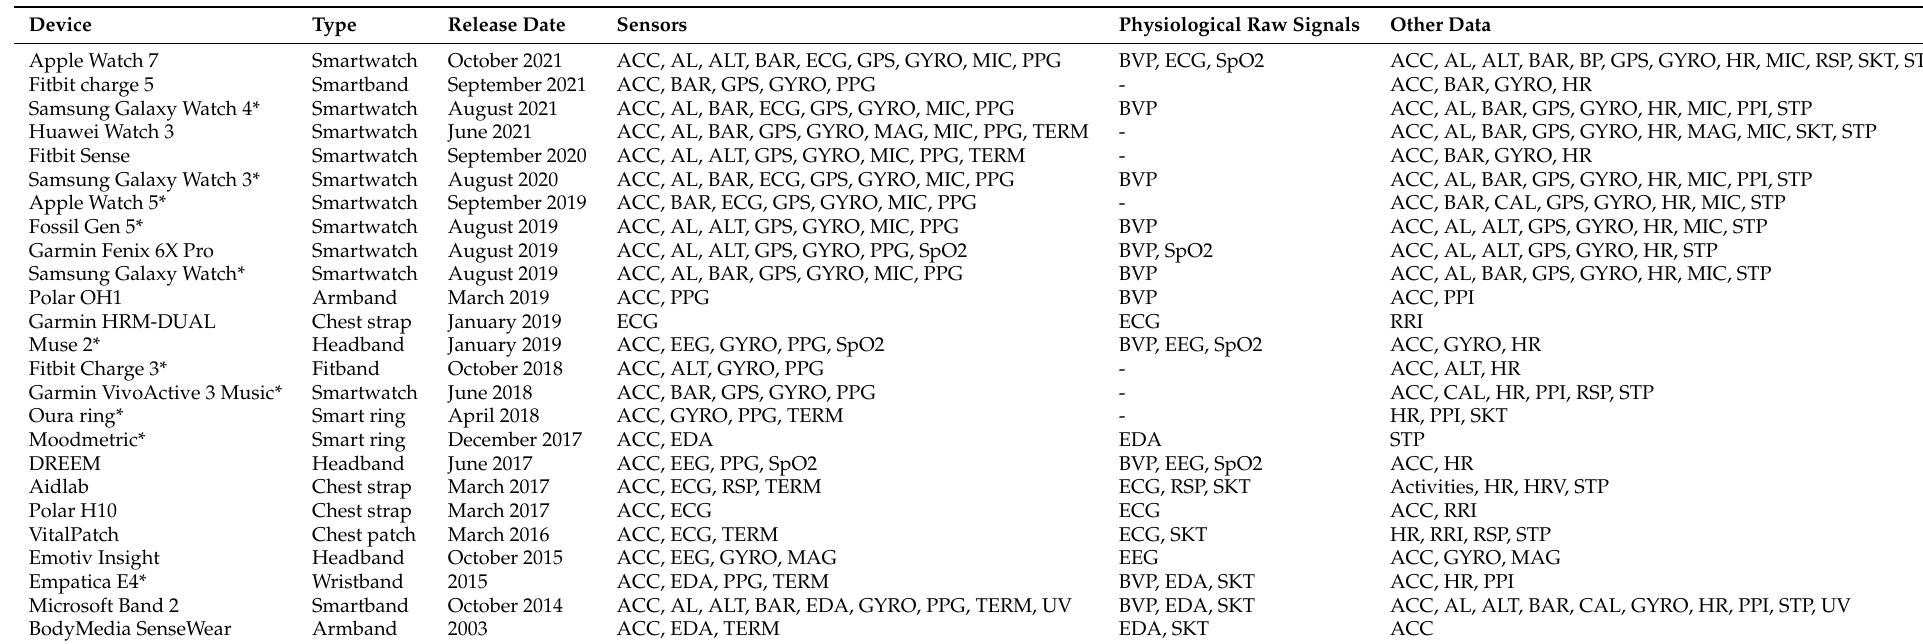
Table 1. The recent commercially available wearable devices, their sensors measuring physiological signals, and the data they provide; (*) marks wearables tested by the